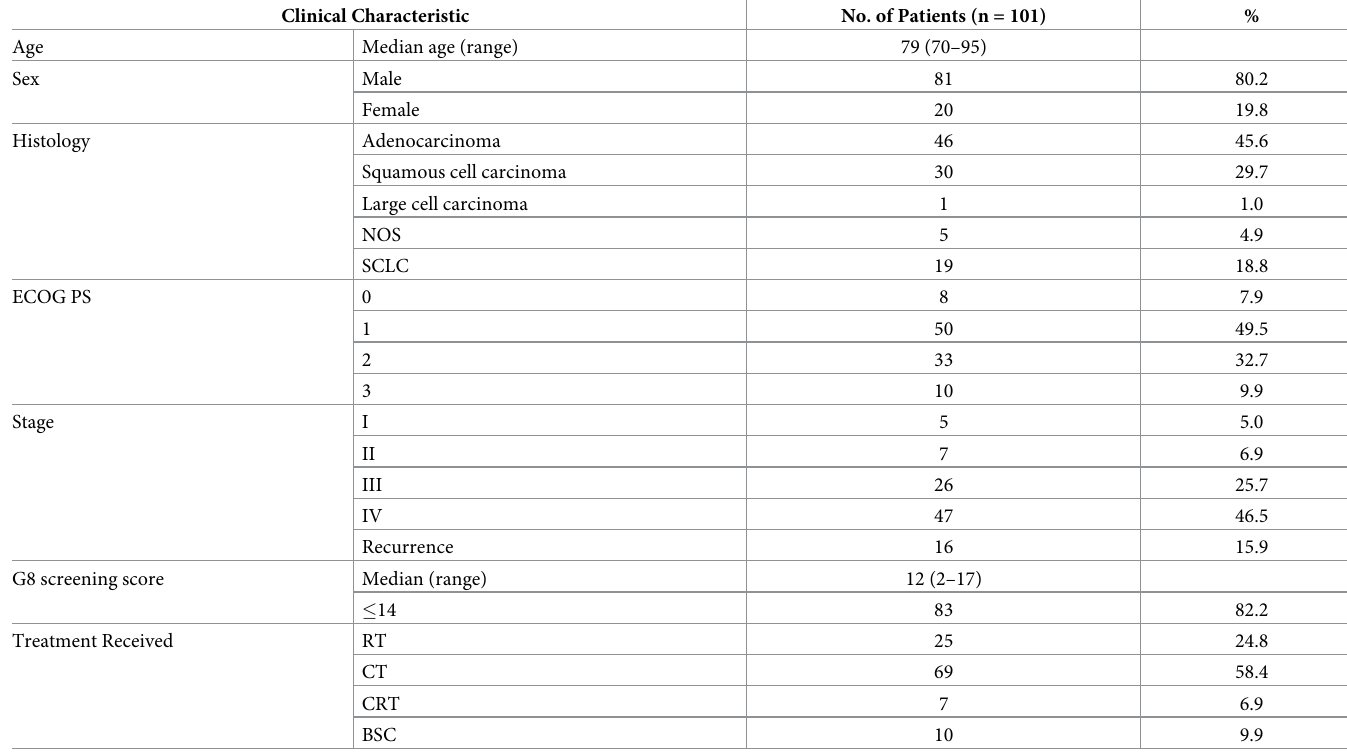
Table 1. Patient characteristics (n =